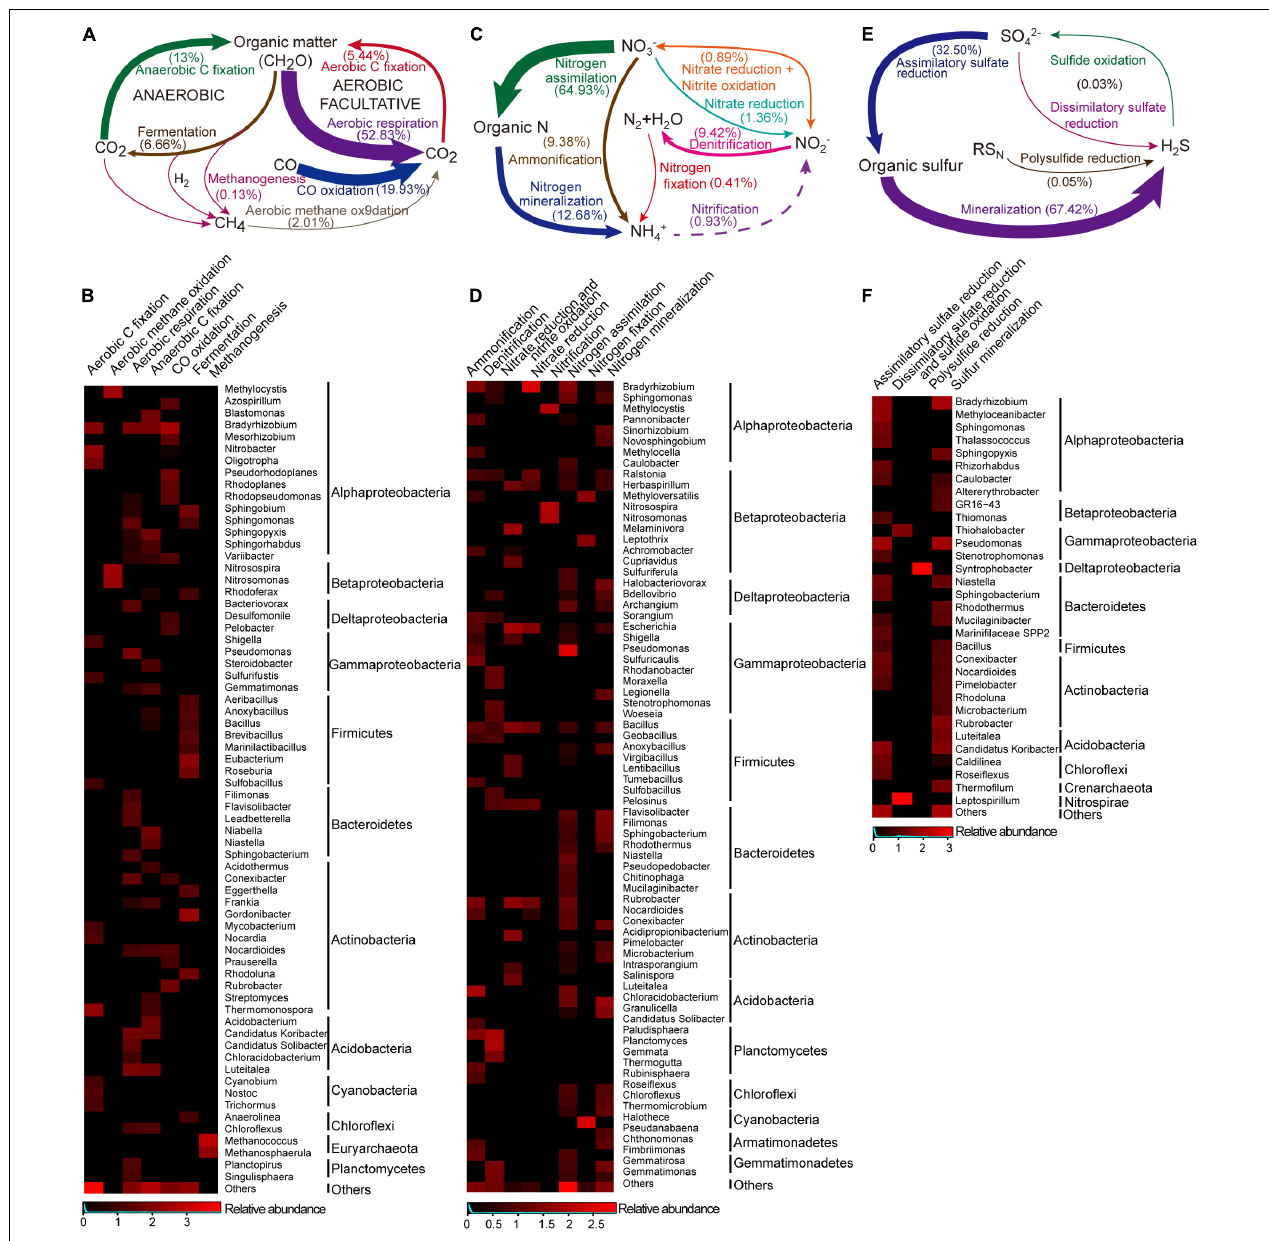
FIGURE 5 | The carbon, nitrogen and sulfur cycles and their major taxa in the Union Glacier area. The genetic potential for each conversion step was estimated using a combination of normalized marker genes (Supplementary Table S1) . Arrow size is proportional to the total potential flux (Supplementary Table S6) . Heatmap presented the relative abundances of major microbes (only for those that contributed > 1% of the marker genes mixture) potentially driving each conversion step. Color bars represent the row-scaled value, in which a blue curve illustrates the distribution density percentage. (A) Carbon cycle and (B) its major taxa. (C) Nitrogen cycle and (D) its major taxa. Dotted lines represent not detected marked genes but putative presence of the pathway. (E) Sulfur cycle and (F) its major